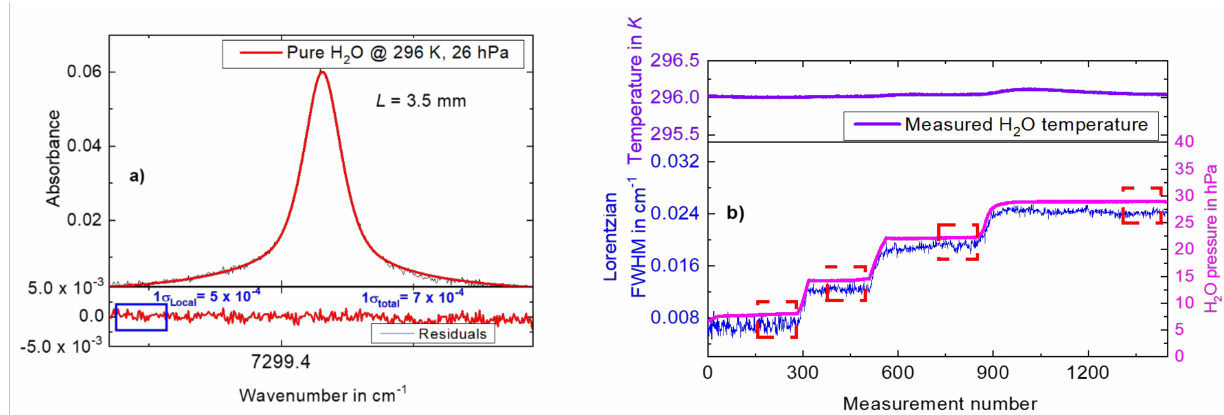
Figure 2. ( a ) Plot of measured—purely self-broadened—spectra of H 2 O at 296 K as a function of wavenumber. A Voigt profile is fitted to the data. Residuals of the Voigt fit are plotted in the bottom panel. ( b ) Bottom panel : Lorentzian width measured at different H 2 O pressures as a function of measurement number. The red dashed rectangular boxes represent the data region chosen for the determining of Ƴ H2O (repeatability — 50 measurements: 0.6%, 0.05%). Top panel : The gas temperature over the entire measurement time.